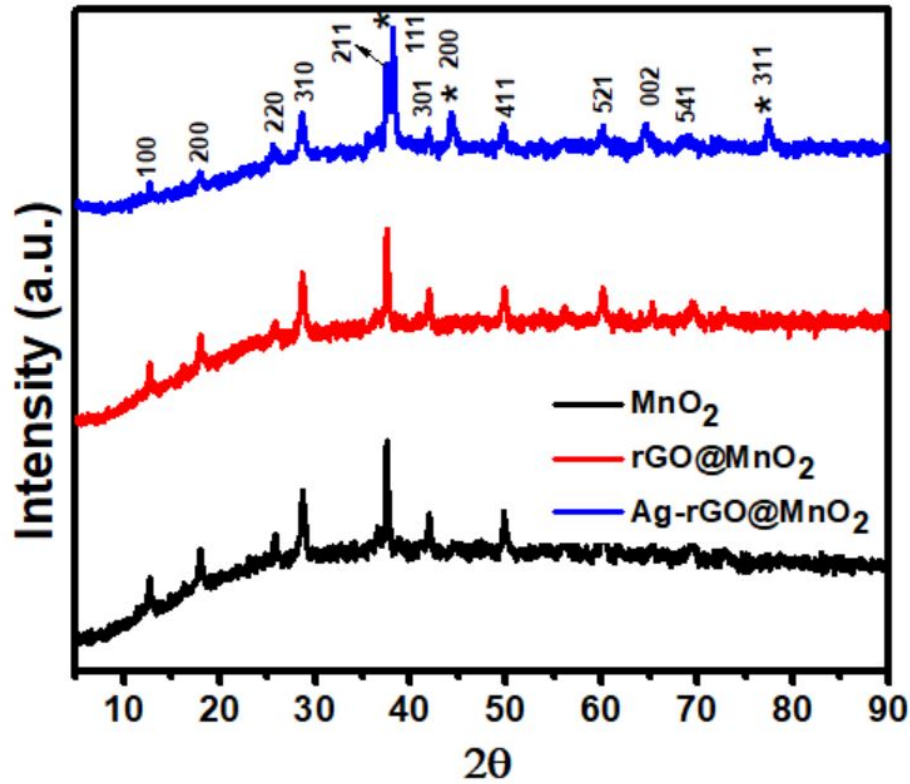
Figure 2. XRD of prepared MnO 2 rods, rGO@MnO 2, and Ag-rGO@MnO 2 nanocomposite. The aster- isk (*) shows the peak positions of Ag.